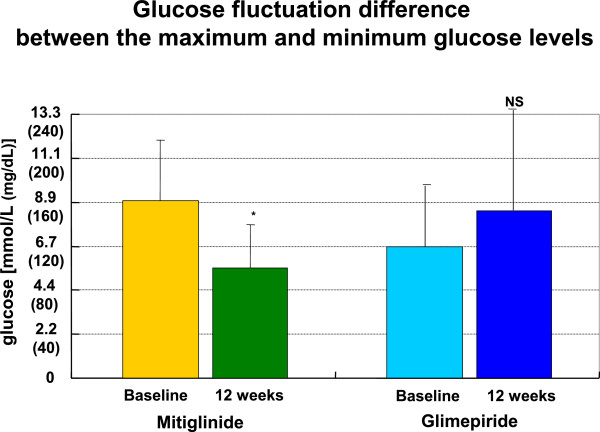
Glucose fluctuations difference between maximum and minimum glucose levels in SMBG. Mitiglinide but not glimepiride improved postprandial glucose level by SMBG.